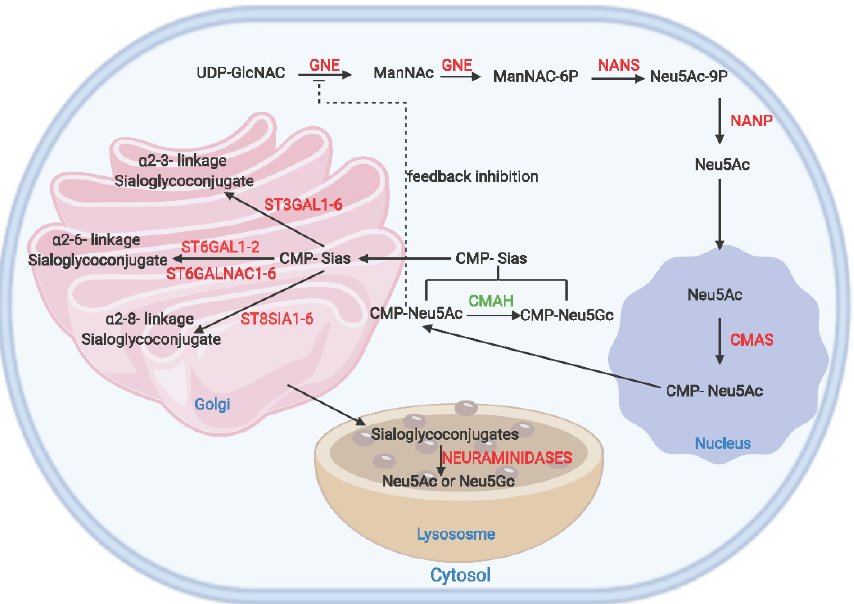
Figure 2. The sialic acid metabolic pathway. The schematic shows the different enzymes involved and each step’s respective localization. Feedback inhibition by CMP-Neu5Ac on GNE is also shown. The CMAH that biosynthesizes Neu5Gc is highlighted in green ( CMAH ). The pathway is modified from the REACTOME sialic metabolic pathway [25]. Created with BioRender.com (accessed on 9 March 2022).